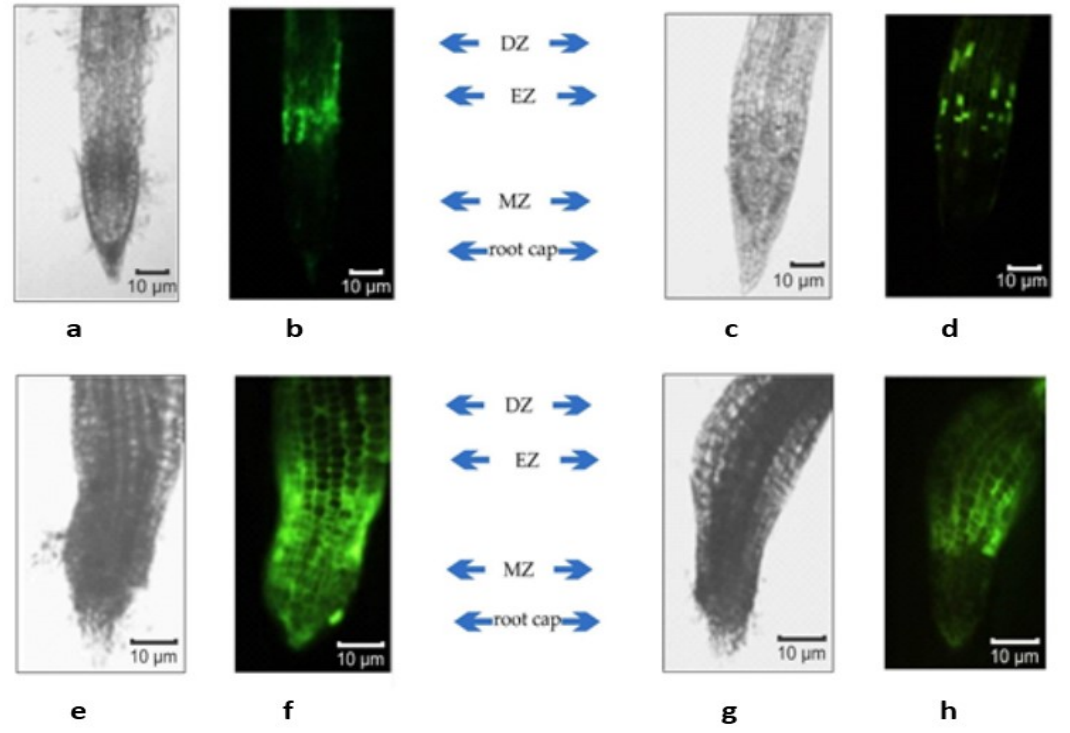
Figure 5. Distribution of ROS+ and ROS—cells in the zones of 28 days tobacco roots. ( a , b ) Control; ( c , d ) in the presence AEDL; ( e , f ) in the presence 150 mM NaCl; ( g , h ) in the joint presence AEDL and 150 mM NaCl. Bar—10 µm.